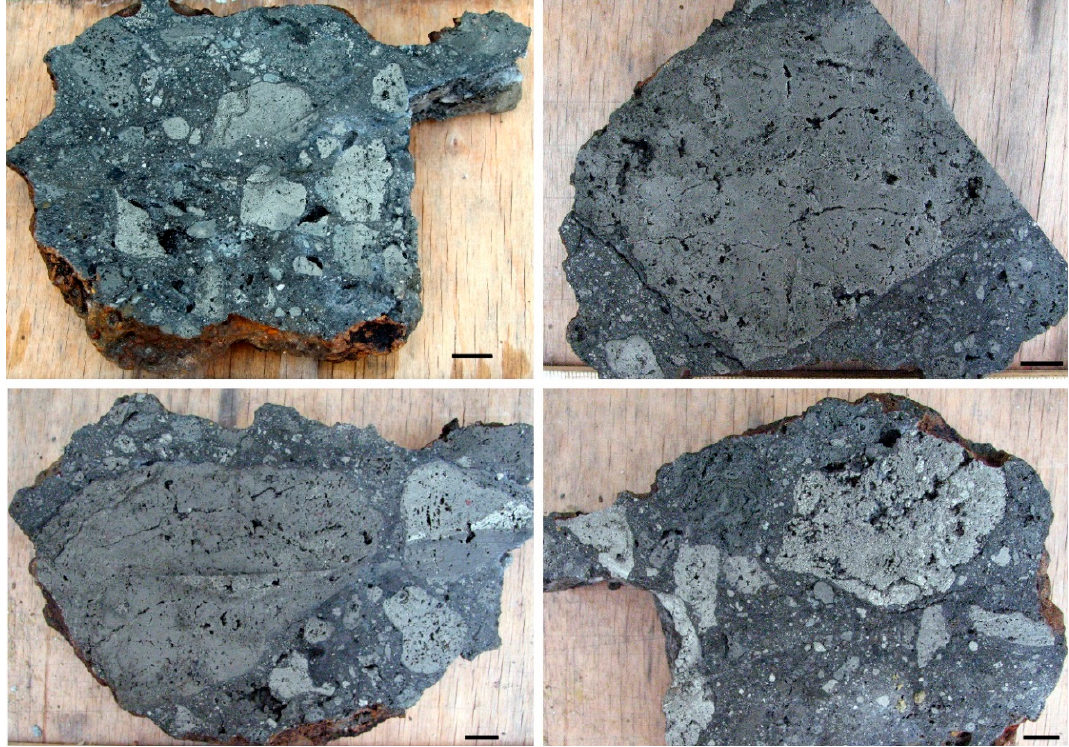
Figure 2. Sulfide breccias from the Semenov ‐ 3 hydrothermal field (on ‐ board photographs). The scale bar is 1 cm. bar is 1